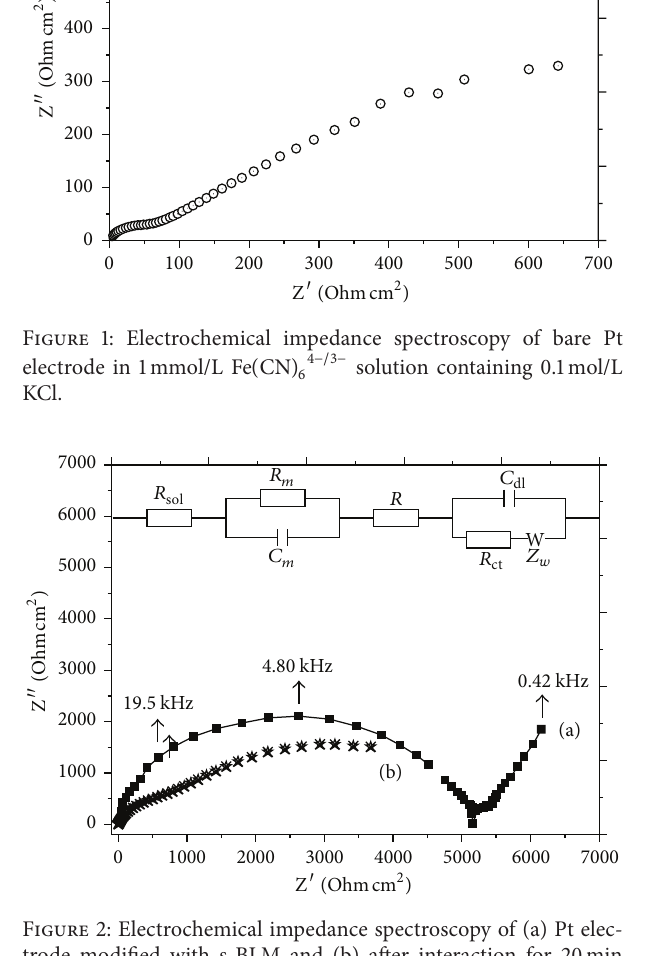
denotes sol 𝐶 denotes the double dl ct